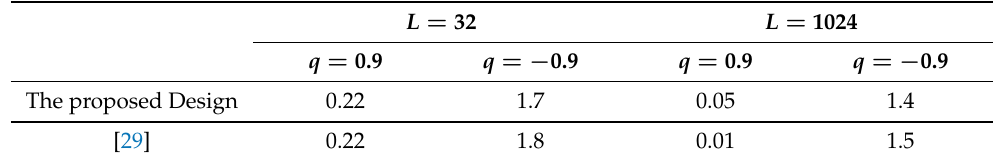
Table 5. Comparison between the maximum errors of the proposed implementation and [29] for sine signal.